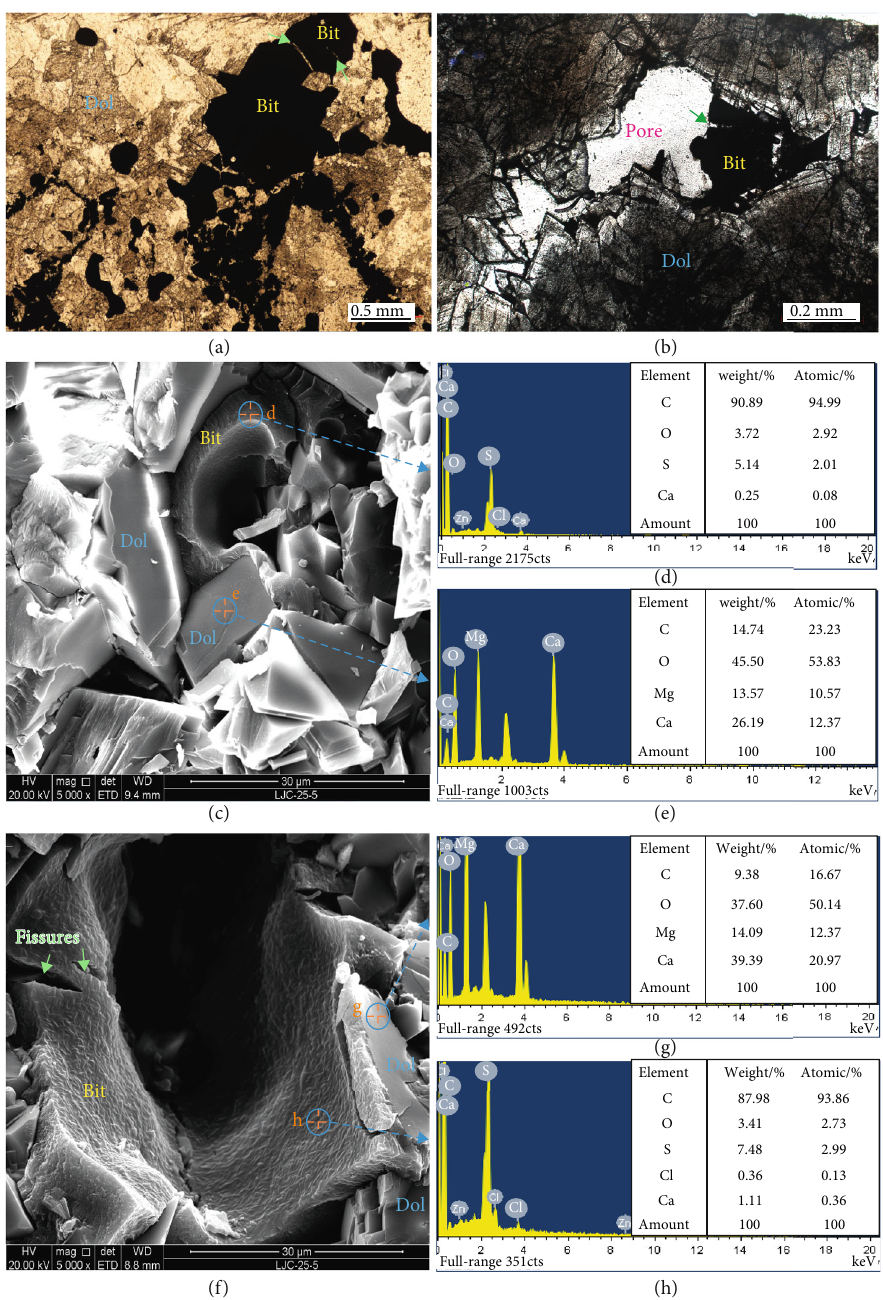
Figure 4: Chart of pore and fi lling mineral morphology of the CS well #1 Z dn 4 member. (a) Bitumen is displayed as a patchy fi lling, and the 2 contracted interval cracks of bitumen are mostly visible (sample depth is 8,161.07m); (b) semi fi lling of bitumen in intergranular solution pores (sample depth is 8,154.39m); (c) bitumen fi lling in recrystallised dolomite intergranular solution pores, where bitumen morphology is annular and attached to the cave wall (sample depth is 8,157.79m); (d) and (e) diagram of principal component analysis of minerals; (f) bitumen in the solution pores is attached to the wall of the hole in a ring shape, and the morphology of bitumen is complete. Two contracted interval cracks are visible (sample depth is 8,159.62m); (g) and (h) analysis of the main mineral components in